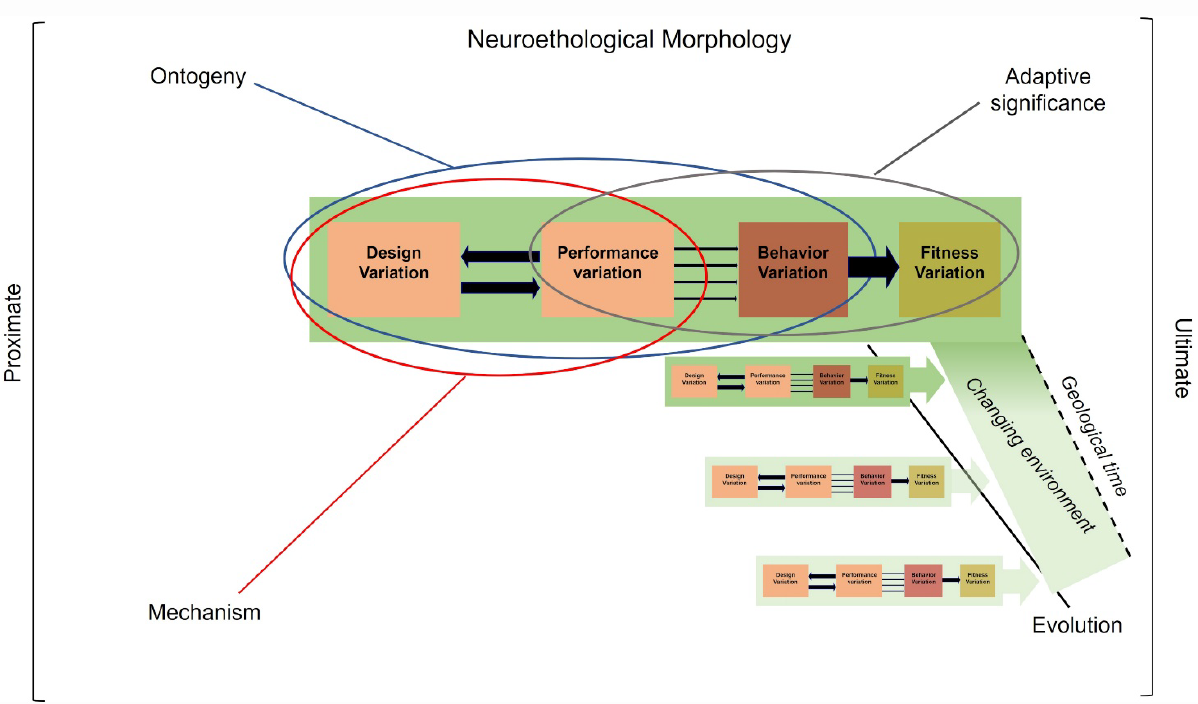
Figure 11. Neuroethological morphology’s heuristic approach to integrating Arnold’s paradigm [47] into Tinbergen’s four causes of behavior: ontogeny (development), mechanism, adaptive significance, and evolution. Certain links play a major role in our understanding of the causes of behaviors. The ontogeny of behavior is mainly concerned with the links between structures and performance (blue ellipse). Mechanism is primarily concerned with the links between structure, performance and behavior (red ellipse). Adaptive significance is mainly concerned with the links between performance, behavior and fitness (grey ellipse). Evolutionary pathways (black line) concern all links between structure, performances, behavior and fitness during changes in environments over geological time. Green rectangles: environments (see Figure 10).